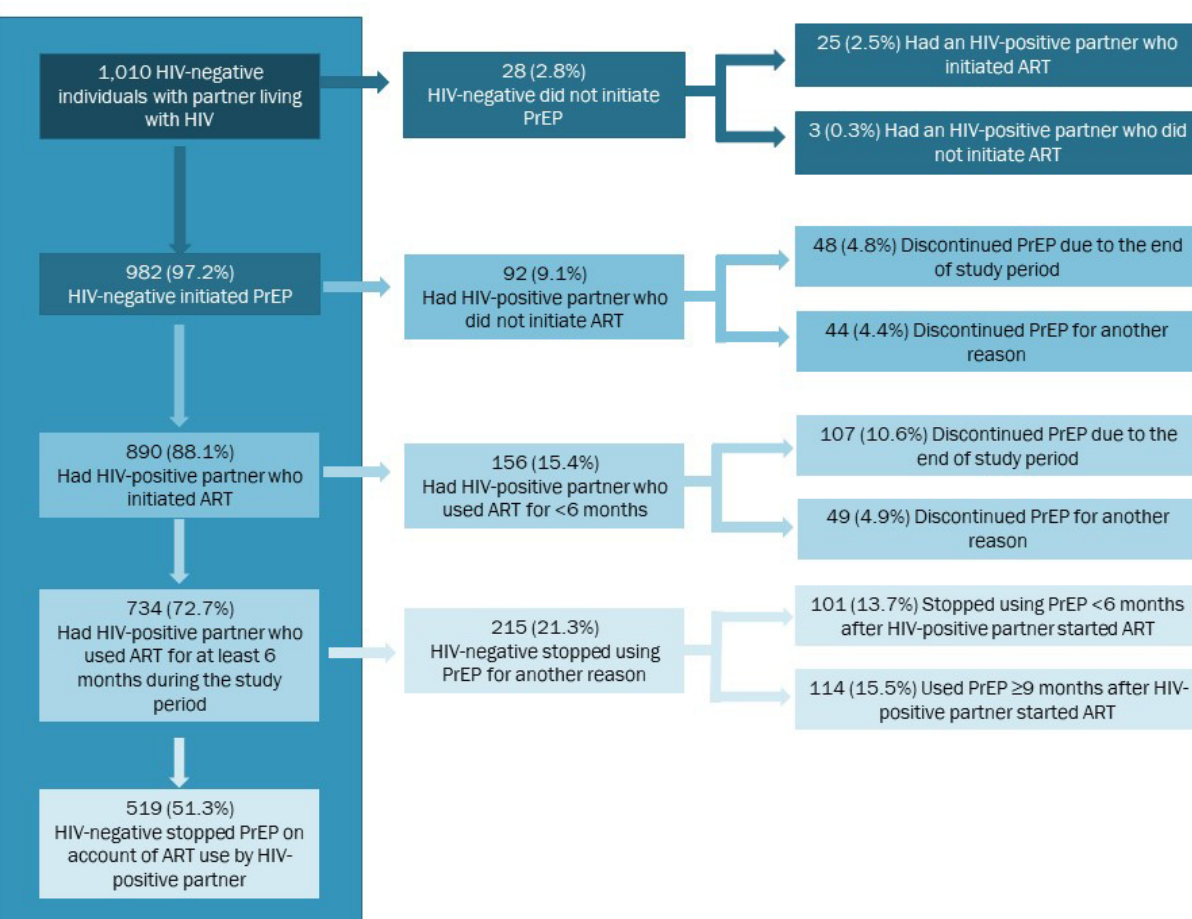
(64.9%, Figure 3, orange sections). When PrEP was not dispensed (Figure 3, green sections), 46.6% included time when no sex with the study partner living with HIV was reported. Of the remain- ing time without PrEP, 26.1% of time without PrEP was due to a protocol-defined event (pregnancy, abnormal serum creatinine measurement, etc.) and 24.8% was due to participant decision.